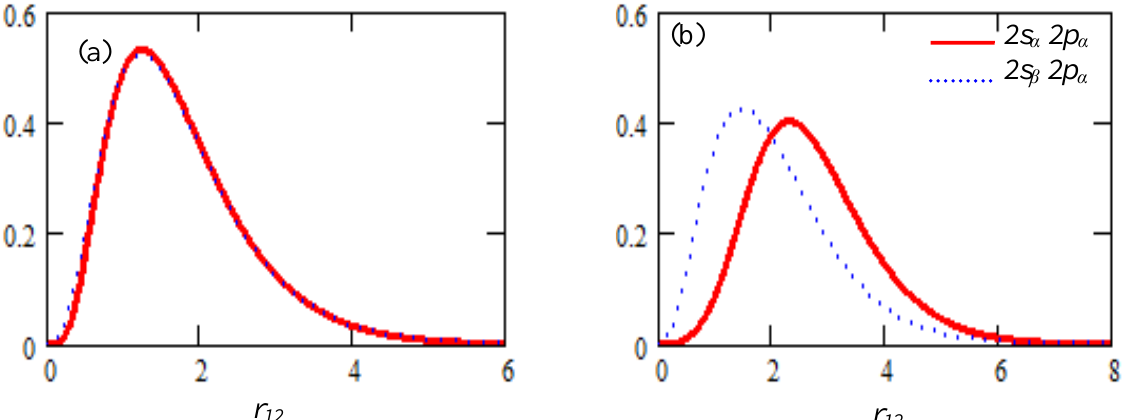
Fig. (3). The inter-particle distribution function f(r